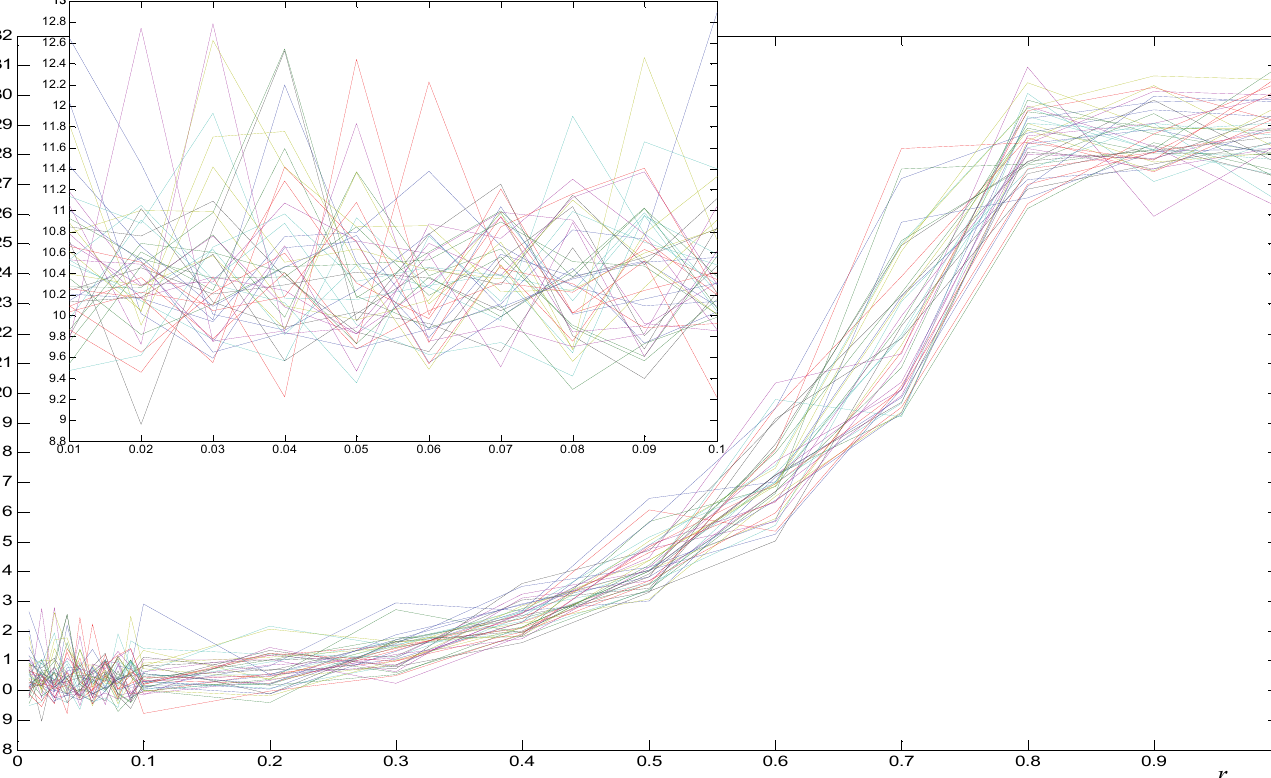
Fig. 3. A bunch of 40 functions (8) for 2LP (22) on the 19-pointed subset (27) showing how CEP is badly scattered (that implies the statistical accuracy is about the magnitude of the CEP scattering, at each PSTSSDR point). The scattering is worse at the top PSTSSDR points, and it appears the least about the solution.